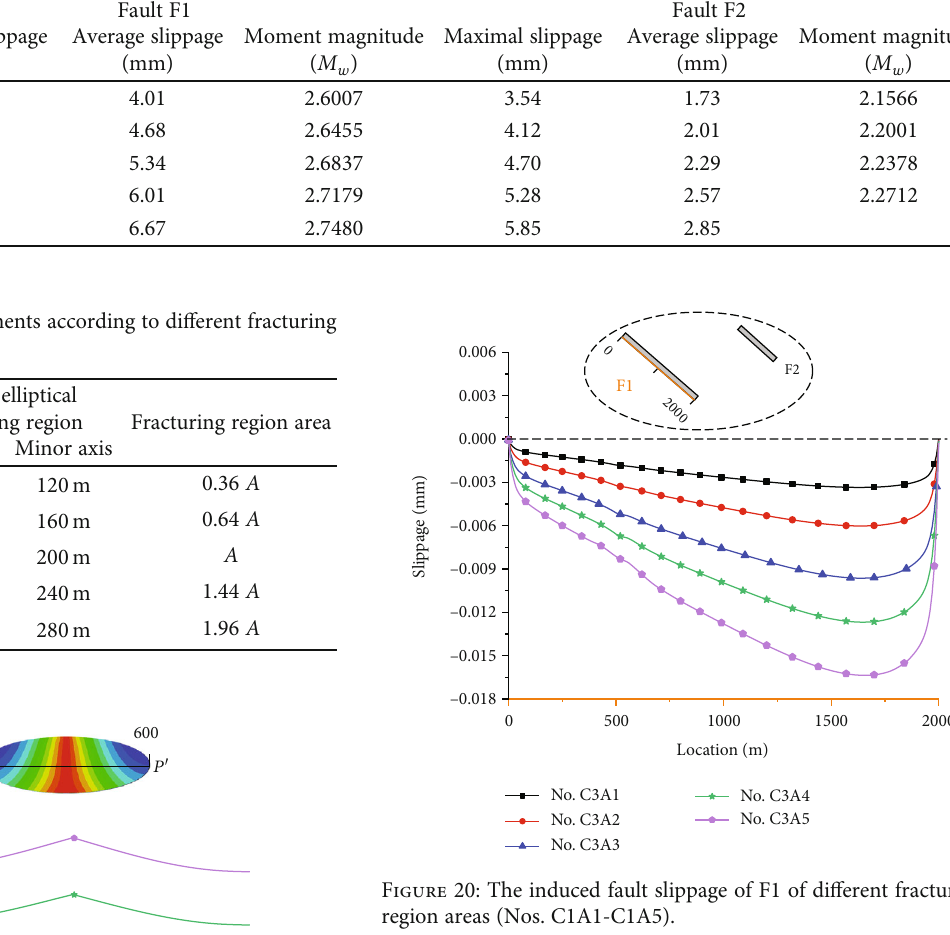
Table 9: The induced slippage and moment magnitude of faults F1 and F2 under di ff erent fracturing patterns. Experiment